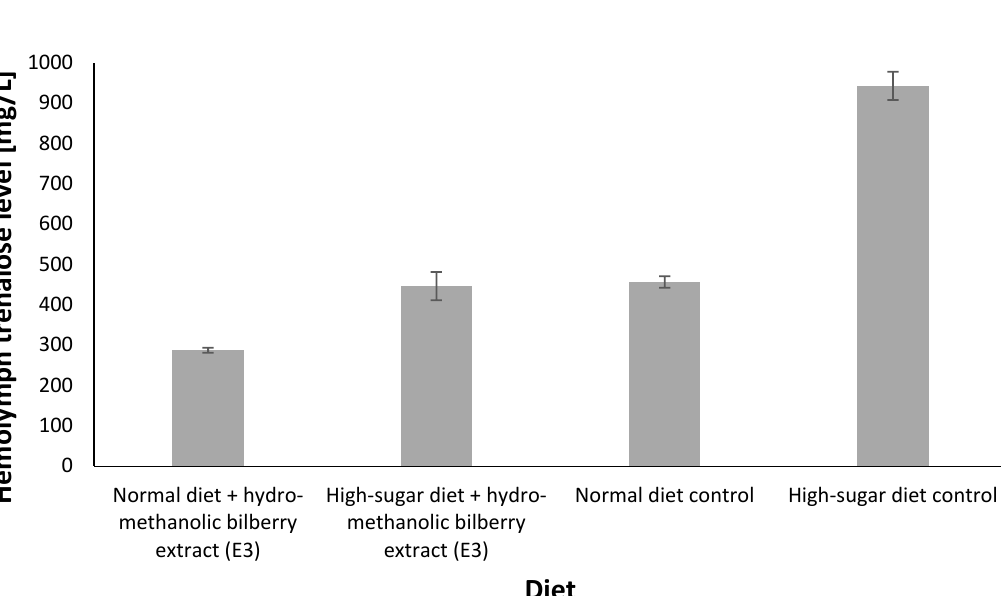
Figure 3. Hemolymph trehalose levels for Drosophila melanogaster Canton Special exposed to high-sugar diet with and without supplementation of hydro-methanolic bilberry extract (E3). Data are reported as average of triplicate experiments, based on Table S8.